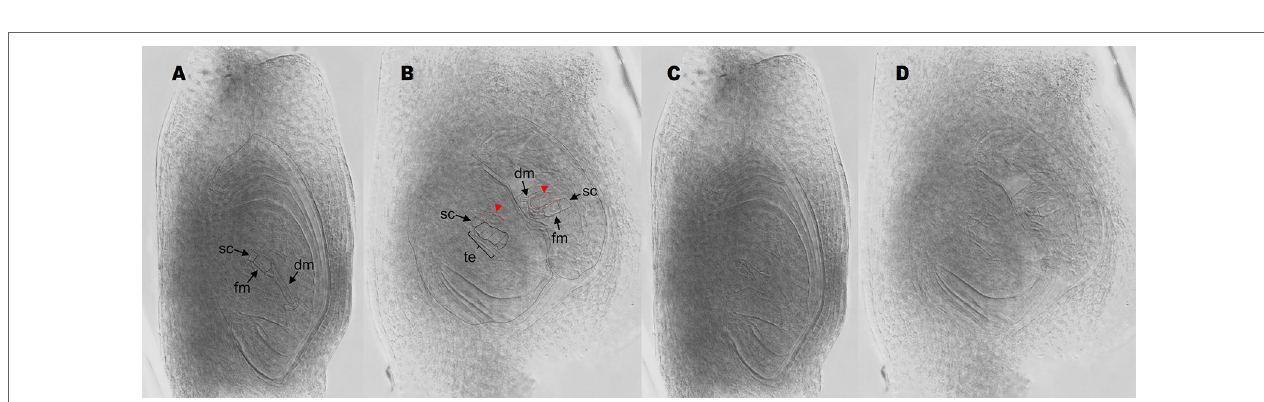
FIGUre 3 | Antisense lines form twin ovules. (A) single ovule with a stack cell, a functional megaspore, and degenerating megaspores. (B) twin ovules originated from antisense plant E2.9. The ovule on the left bears a stack cell, a meiotic tetrad and two adjacent enlarged nuclei (red arrows/red dotted lines). The ovule on the right shows a stack cell, a functional megaspore, degenerating megaspores and two adjacent enlarged nuclei (red arrows/red dotted lines). (c , D) same images as in (A and B) , respectively, but the ovule boundaries were unmarked for an easier viewing of the cell boundaries. sc, stack cell; fm, functional megaspore; dm, degenerated megaspores; te, meiotic